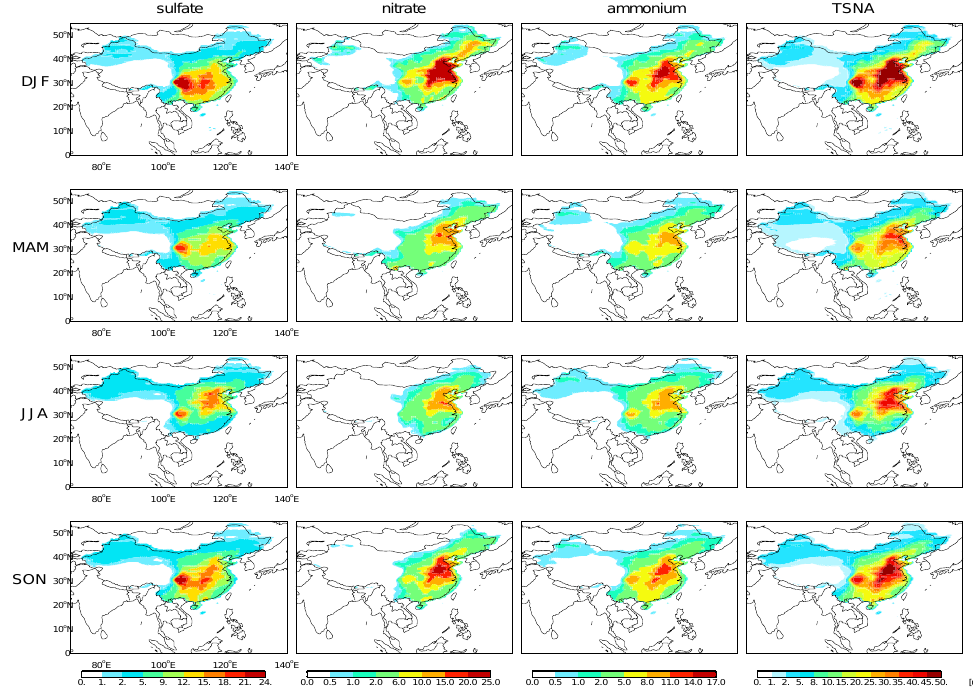
Fig. 9. Simulated seasonal mean surface concentrations of sulfate, nitrate, ammonium and TSNA (left to right) in December–February (DJF),